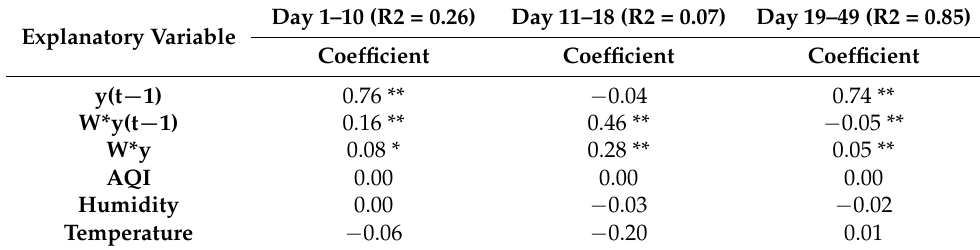
Table 3. Parameter estimates of the DSAR model.